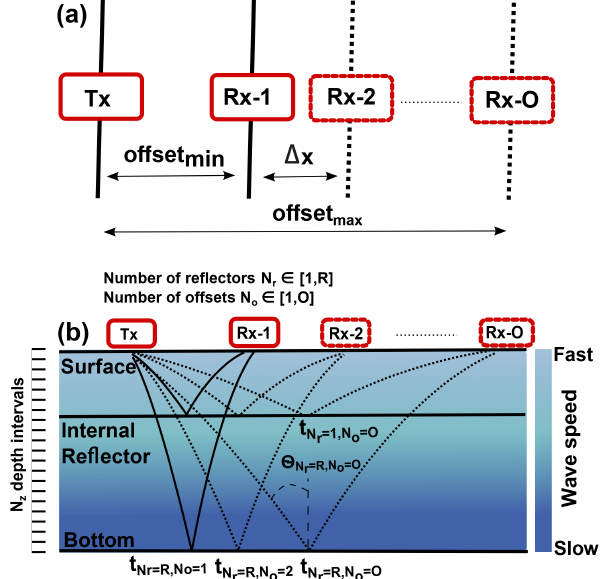
Figure 1. (a) Plain view of the wide-angle acquisition geometry: transmitting (Tx) and receiving (Rx) antennas were aligned in parallel. While the transmitter remained at a fixed location, the receiver was incrementally moved farther away. A sketch of the corresponding ray paths is shown in (b) with a synthetic velocity–depth function color coded. The labels of example rays and their incidence angles are presented in Eqs. (1)–(10).